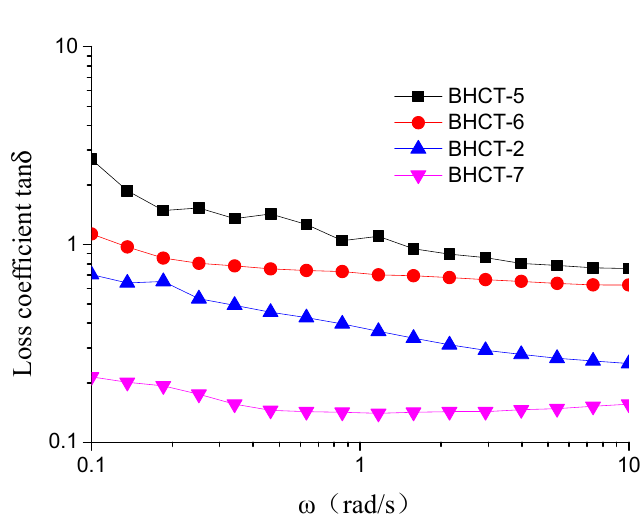
Figure 13. Loss factor of composite gels with different bentonite contents.